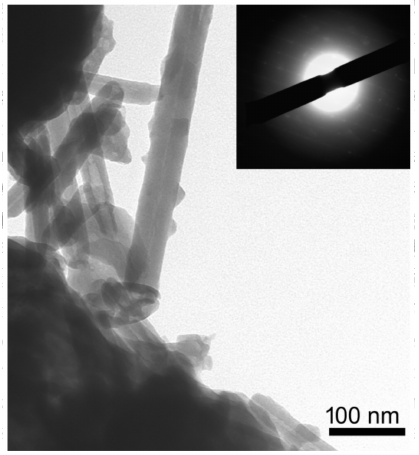
Figure 10. TEM image of chrysotile and corresponding SAED pattern after 10 min of